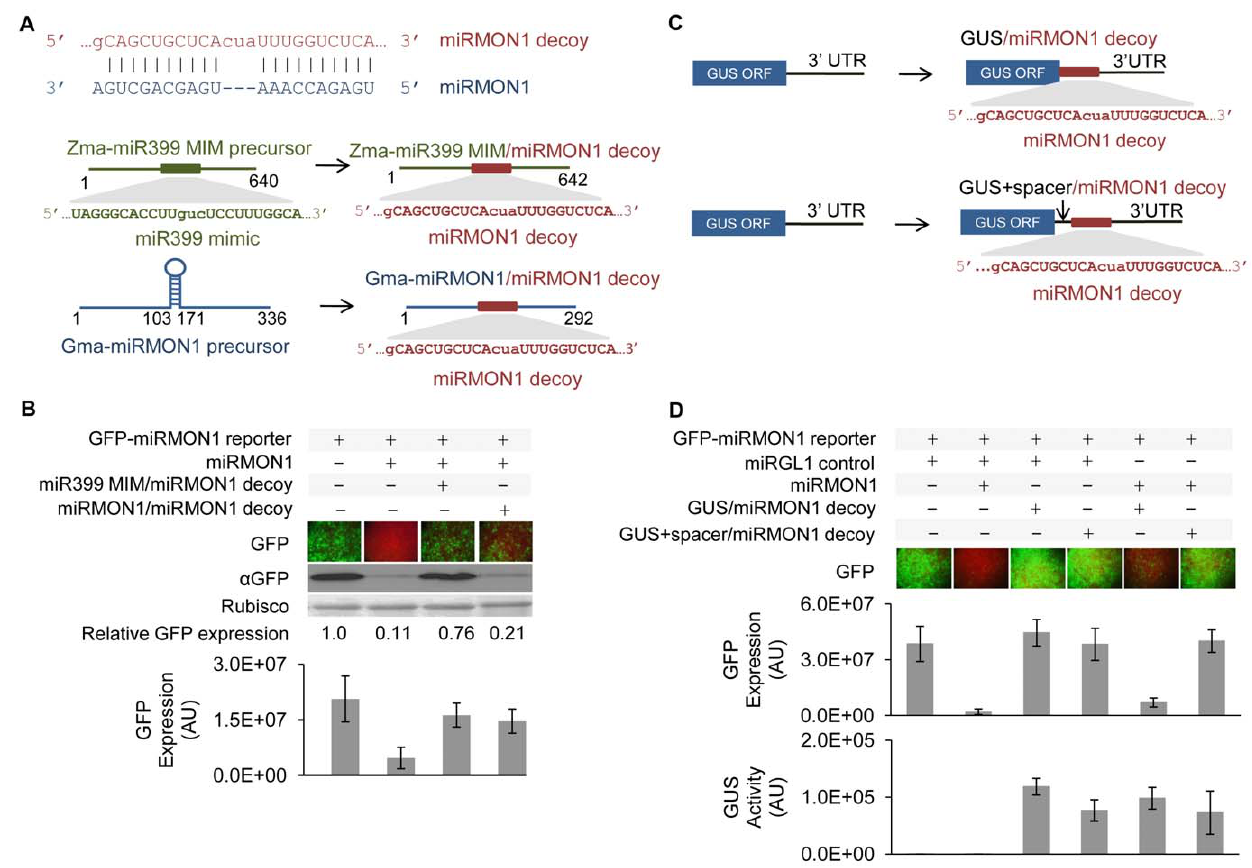
Figure 1. Effect of different RNA scaffolds on miRNA decoy efficacy. ( A ) miRMON1 bulge decoy sequence and diagrams of miRMON1 decoy embedded in various backbone configurations: miRMON1 decoys in maize non-coding RNA and soybean miRMON1 precursor. ( B ) Expression of miRMON1-targeted GFP reporter co-expressed with miRNA decoys in different scaffolds in N. benthamiana leaves. ( C ) Diagram of miRMON1 decoys in the 3 9 UTR of the GUS coding transcript, with and without a 75 nt spacer after the open reading frame. ( D ) Expression of miRMON1-targeted GFP reporter co-expressed with decoys in a GUS protein-coding cassette in N. benthamiana leaves. GFP expression was measured by fluorescence microscopy and Western blot. The Rubisco band visualized by Ponceau staining shows the loading control. Relative GFP protein expression normalized to Rubisco is indicated. GUS expression was measured by the 4-methylumbelliferone assay. Leaves were co-transformed with one part GFP reporter, 5 parts miRMON1, and 10 parts miRNA decoy. Agrobacterium transformed with an empty vector was added to achieve a total OD 600 =1 of Agrobacterium for each transformation.